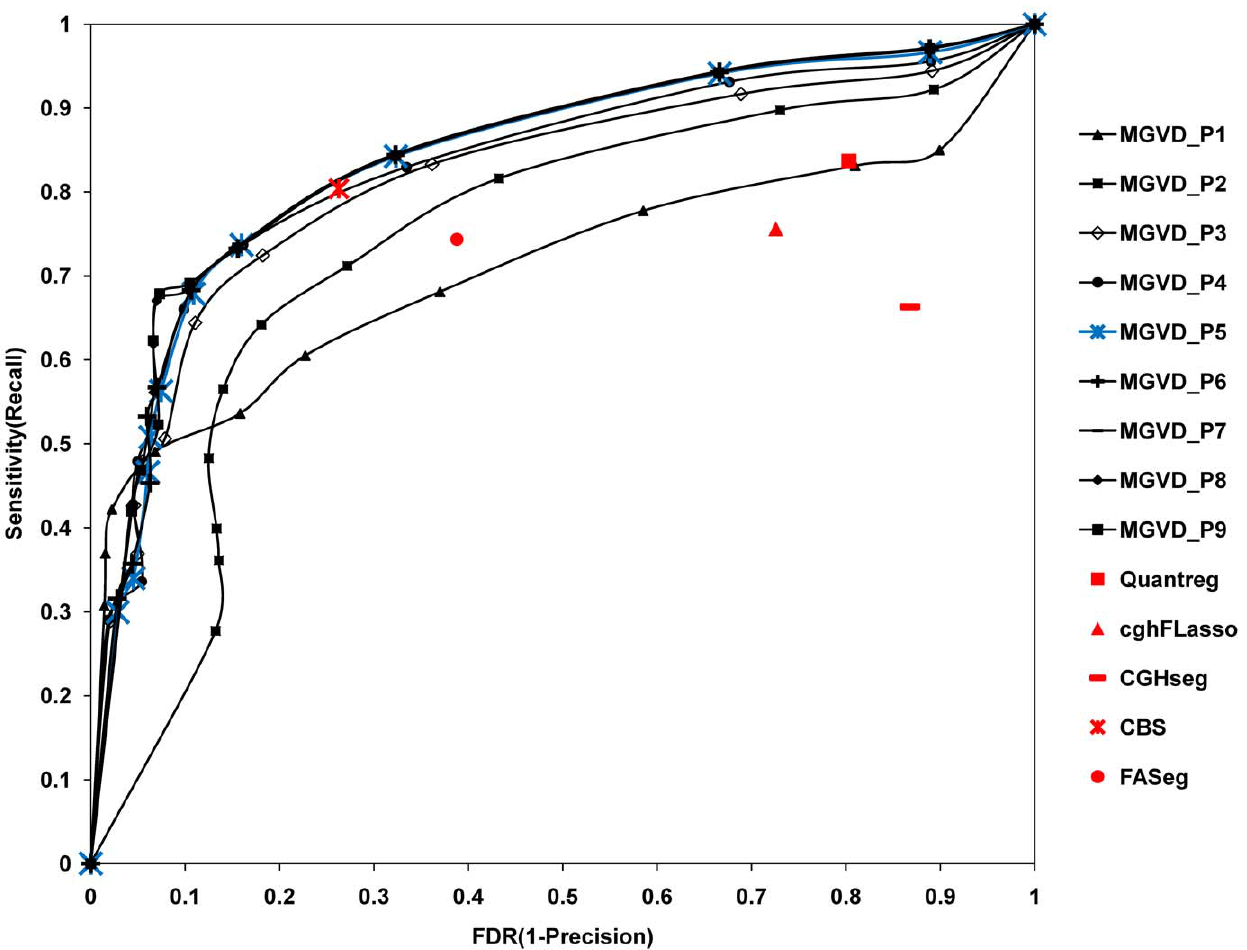
Figure 2. PROC operational curves with 90 parameter sets for real high resolution data for chromosome 22. By varying two parameters of MGVD, 90 different results were generated. Results for the five existing algorithms were obtained using default parameters. MGVD_P5 contains the best parameter set.